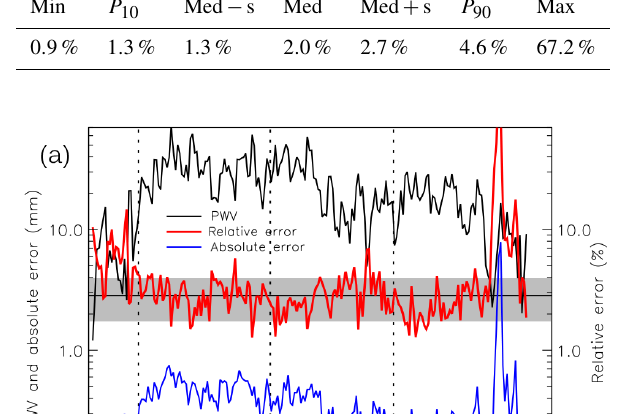
Figure 6. Optimized error (cid:15) (blue pluses and left axis) and opti- mum number of samples N 0 (red squares and right axis) for all the available radiosondes as a function of the PWV value. The ranges of values covered by the two models of radiosondes used (RS80 and RS90) is indicated with the grey arrows.